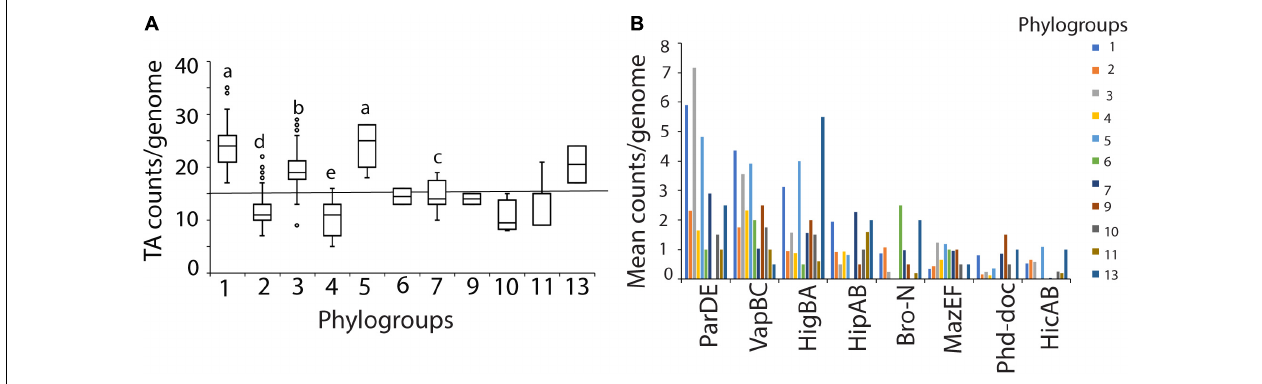
FIGURE 2 | (A) TA counts per genome by phylogroups. The central line shows median number of TA system genes from the 339 strains used. Different letters indicate significant difference in counts as analyzed by Kruskal-Wallis test at P < 0.05. Phylogroups with less than 10 strains were not used in the analysis. (B) Differences in major TA system content among phylogroups. Mean counts per genome by phylogroup are shown. Phylogroups differed in copy number per genome of parDE , vapBC and higBA families (also refer heatmap in Figure 1A